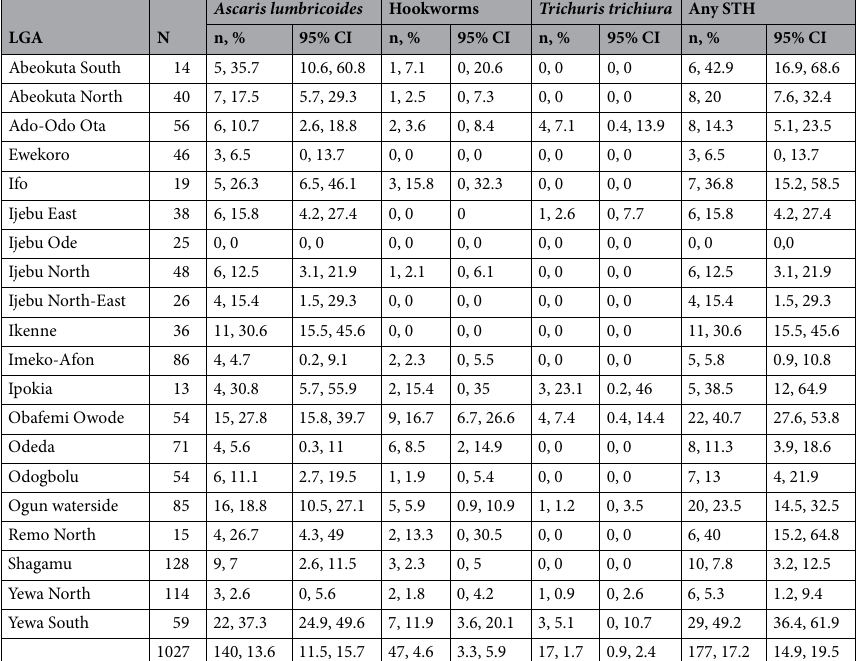
Table 2. Soil-transmitted helminth species-specific empirical prevalence across the 20 LGAs in Ogun State, Nigeria, Mid 2016-Early, 2018. N, number of samples examined; n, number of positives; CI, Confidence intervals.